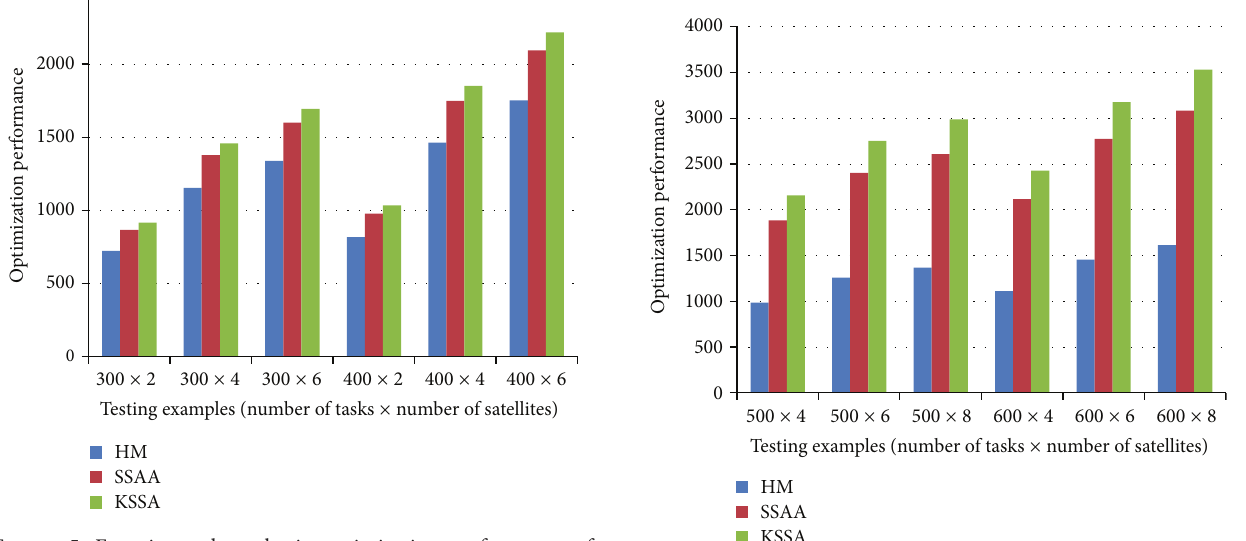
Figure 5: Experimental results in optimization performance of medium scale testing examples.